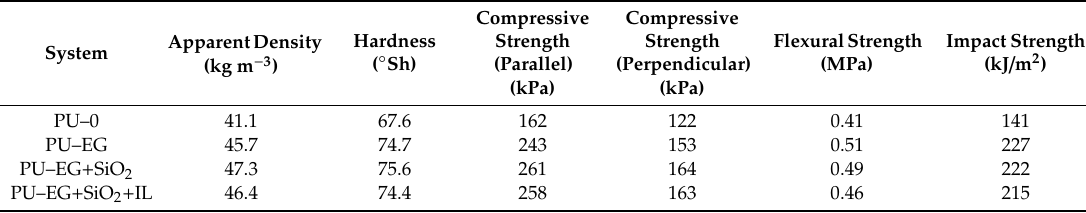
Table 3. Mechanical properties of PU